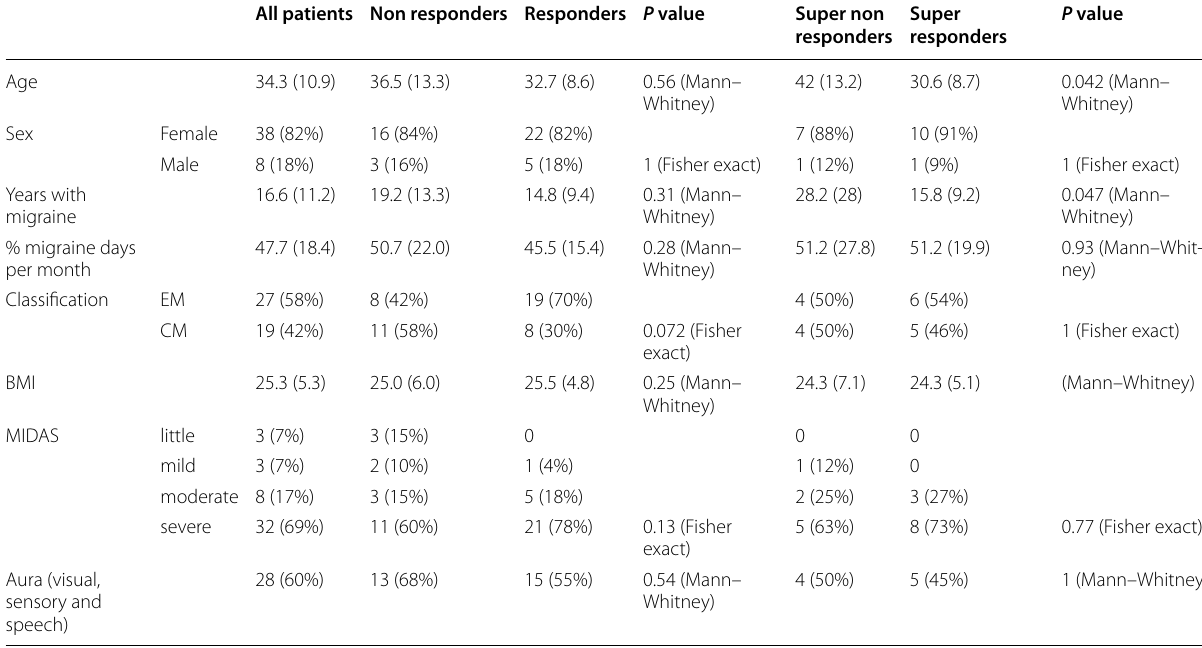
Table 3 Baseline demographics, classifications, and disease characteristics of all, non‑responders, responders, super